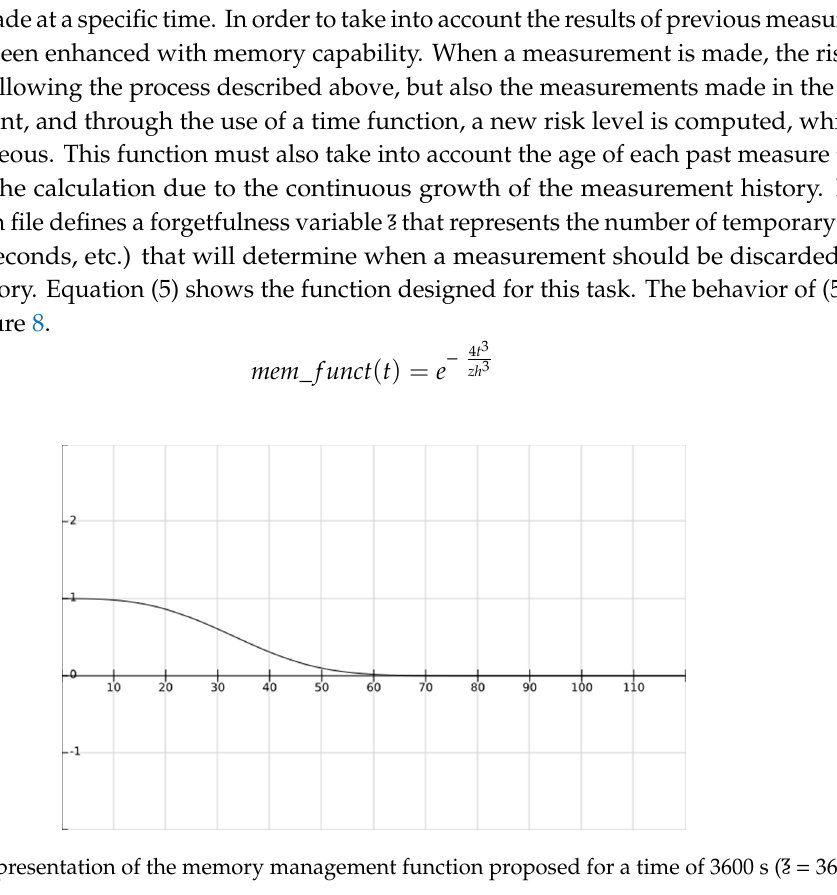
Figure 8. Representation of the memory management function proposed for a time of 3600 s ( ƺ = 3600).